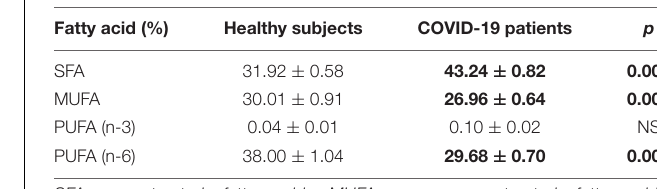
TABLE 7 | Fatty acid compositions of the phospholipids; saturated, monounsaturated, and polyunsaturated in the plasma from the healthy subjects and COVID-19 patients.